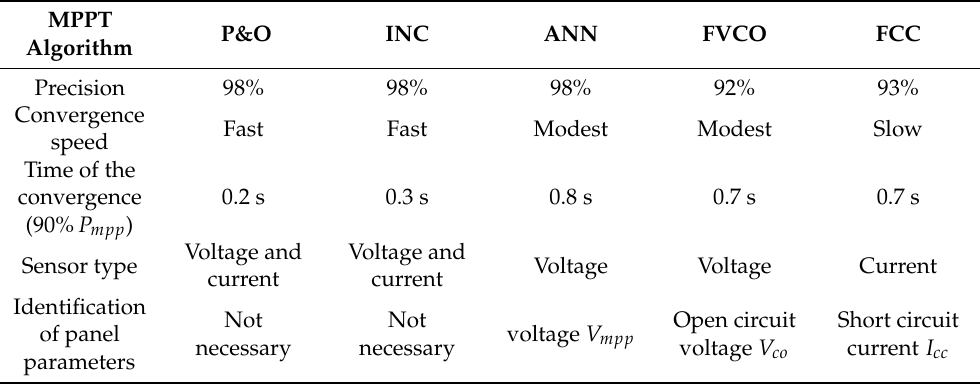
Table 8. Summary table of the comparison of the five methods